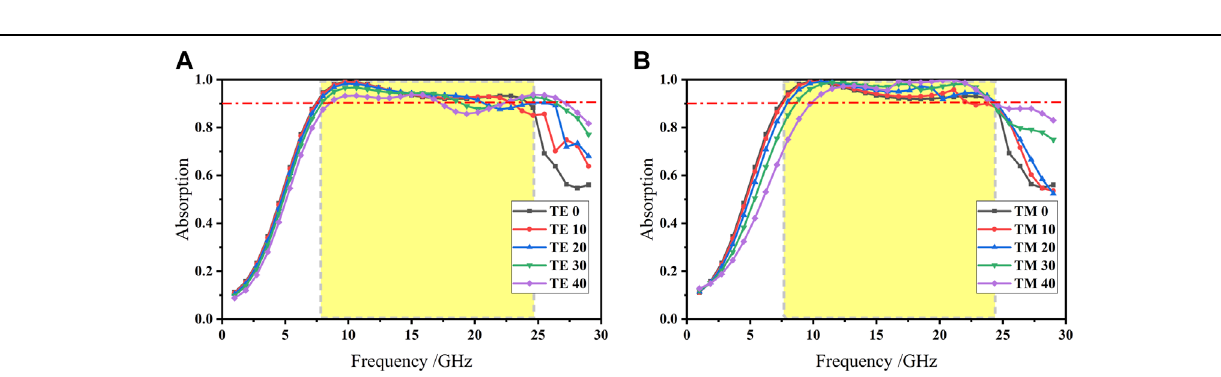
FIGURE 7 | Schematic diagram of the absorption rate at 1 ∼ 29 GHz. (A) is under TE polarization at incident angles from 0 to 40. (B) is under TM polarization at incident angles from 0 to